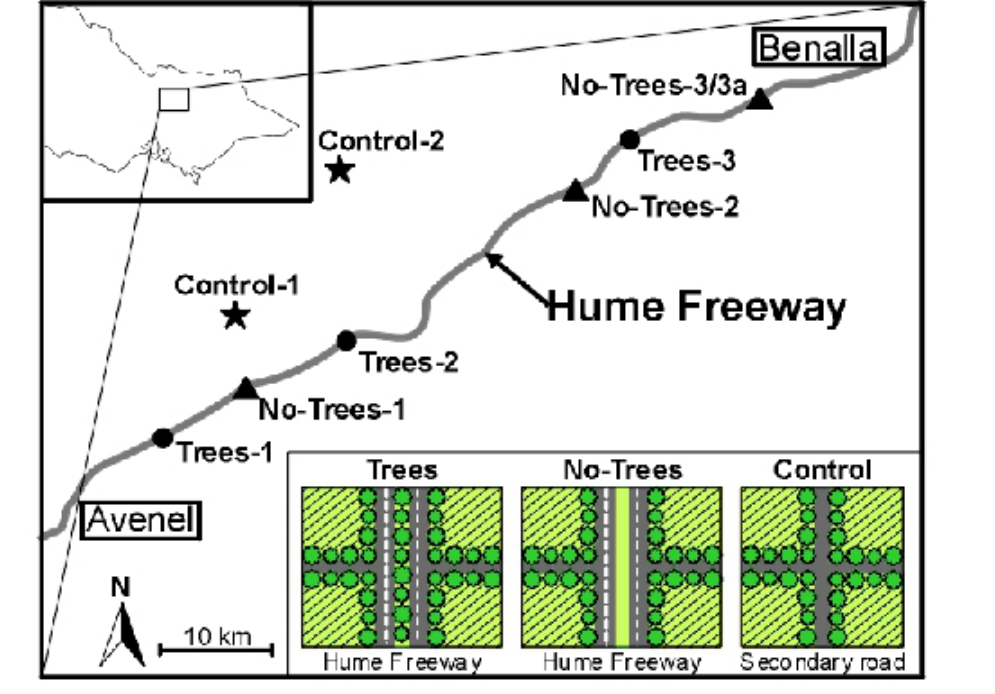
Fig. 1. Location of six sites along the Hume Freeway: circles = sites with trees in the median (Trees), triangles = sites without trees in the median (No-Trees), and two control sites (stars), in northeastern Victoria, Australia (State of Victoria shown in square in top left corner). The insert shows diagrams of the road intersection layout at Trees, No-Trees, and control sites, where diagonal lines indicate cleared agricultural